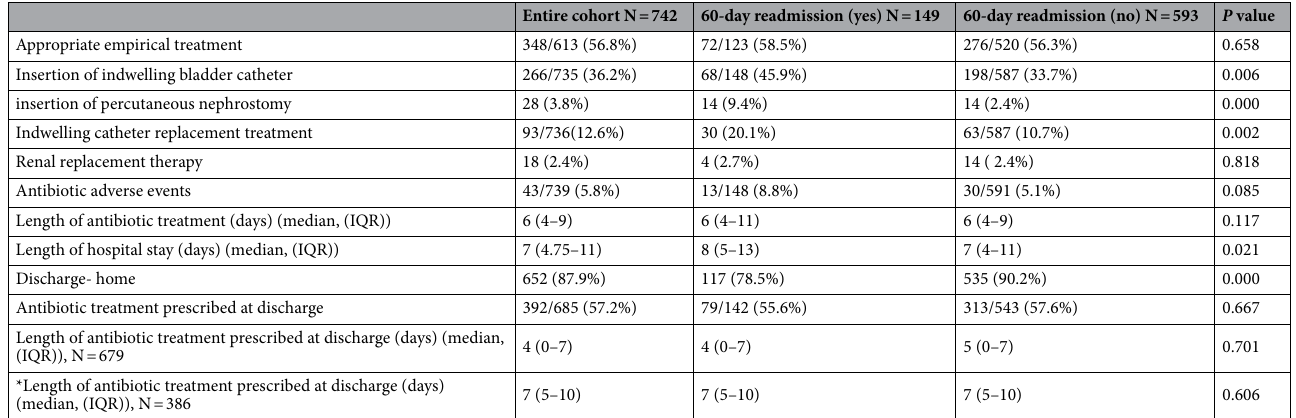
Table 3. Infection management. *Among patients with prescribed antibiotics at